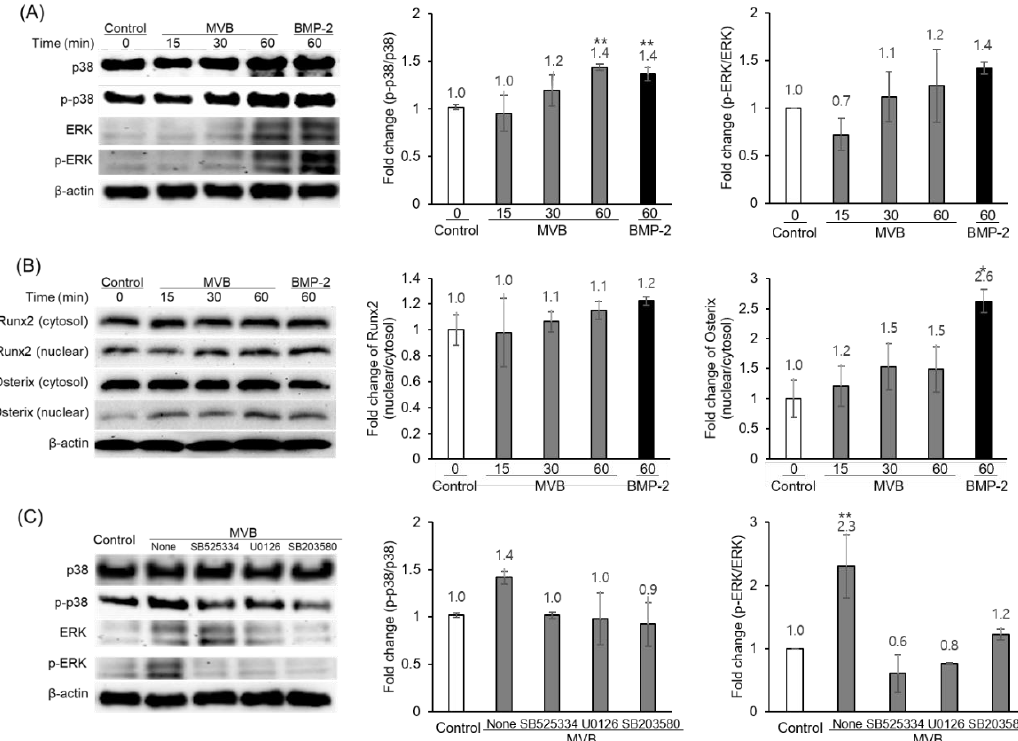
Figure 4. Western blot showing activation of transforming growth factor-β (TGF-β) signaling pathway by MVB treatment in C3H10T1/2 cells. ( A ) Time-course analysis of the non-canonical signaling of TGF-β pathway after treatment with 100 μg/mL MVB. ( B ) Time-course analysis of Runx2 and Osterix after treatment with 100 μg/mL MVB. ( C ) Pre-treating cells with inhibitors of TGF-β signaling pathway attenuated MVB (100 μg/mL)-induced p38 and ERK activation. Significant difference compared with control: * p < 0.05, ** p < 0.01.